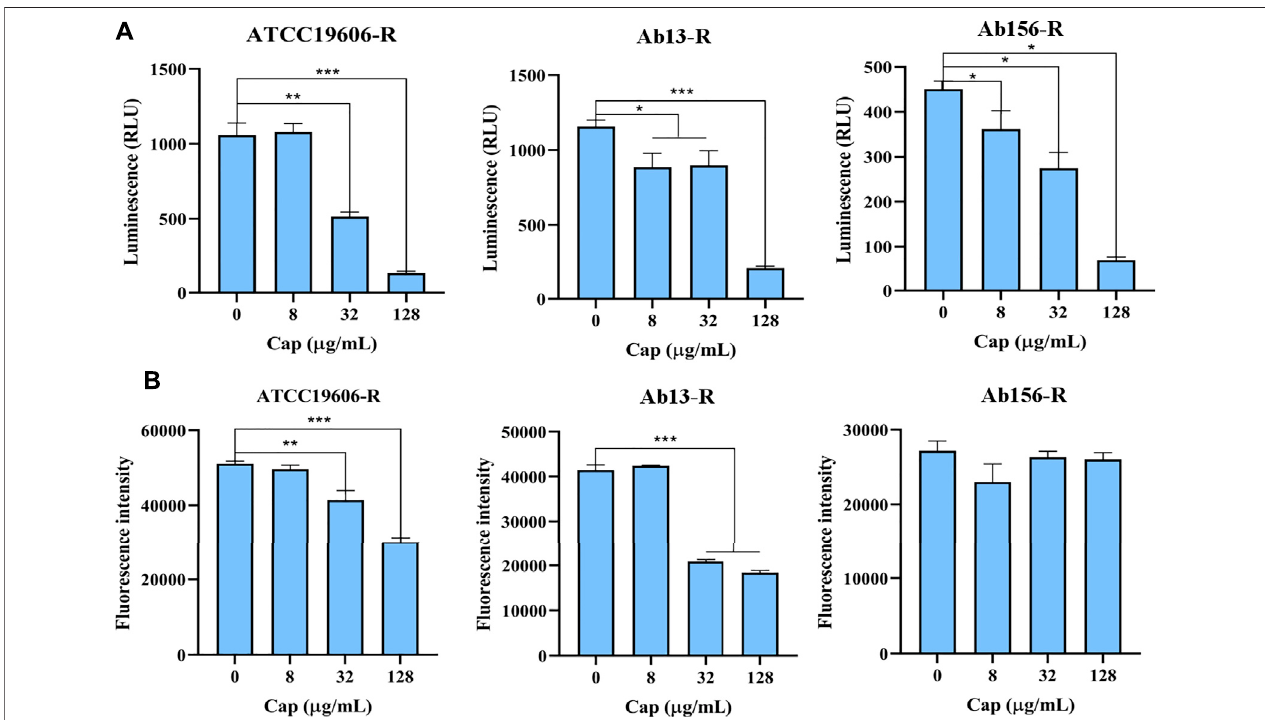
FIGURE6|(A) :IntracellularATPinbacterialcellstreatedwithincreasingconcentrationsofcapsaicin(0 – 128 μ g/mL). (B) :ThechangesoftotalROSof A.baumannii ATCC19606-R, AB13-R and AB156-R detected by DCFH-DA fl uorescent probe after treatment with capsaicin (0 – 128 μ